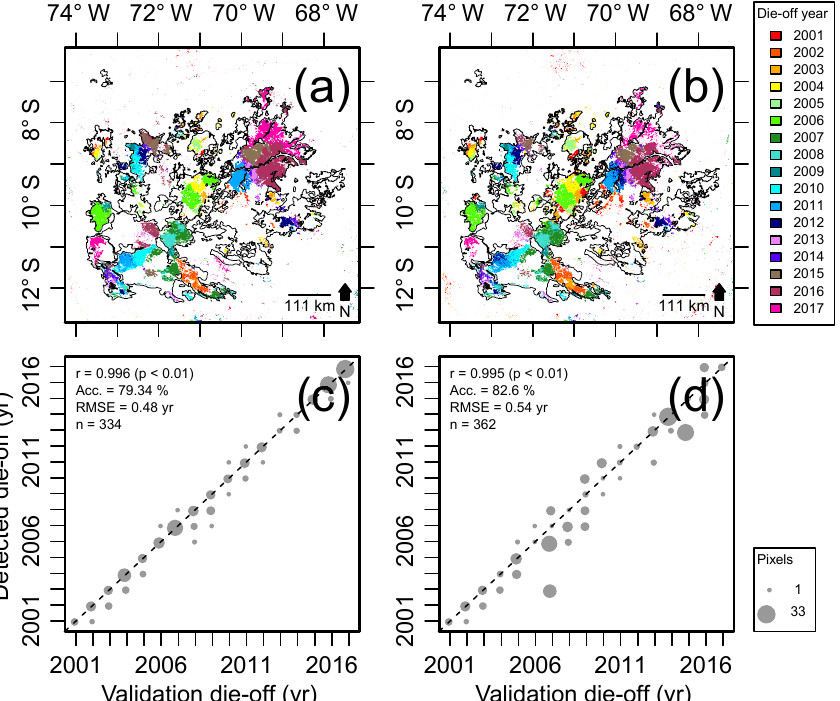
Figure 5. MODIS bamboo die-off detection map from 2001 to 2017 using the bilinear model of expected near-infrared (NIR) reflectance variations as a function of bamboo cohort age, for (a) NIR-1 and (b) NIR-2. Validation between detected die-off and visual interpreted die-off on MODIS false-color composites (2000–2017) for (c) NIR-1 and (d) NIR-2. The dashed line represents the 1 : 1 line. The size of circles is related to the number of pixels that hit the same observed/estimate die-off